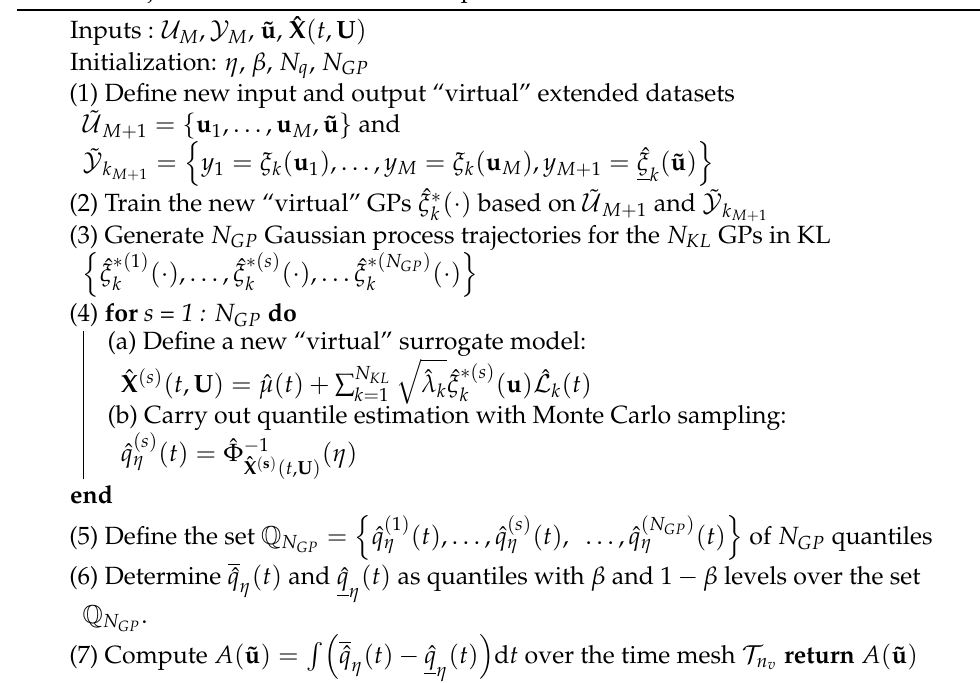
Algorithm 1: Confidence interval area calculation for quantile estimation based on GP trajectories for a candidate sample